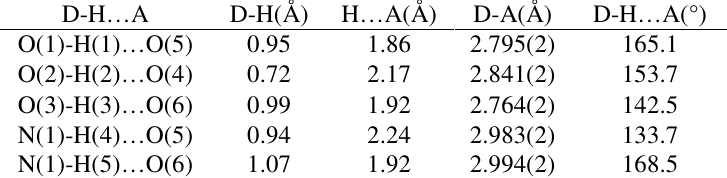
O) [C H N ] (NO 2 6 3 12 2